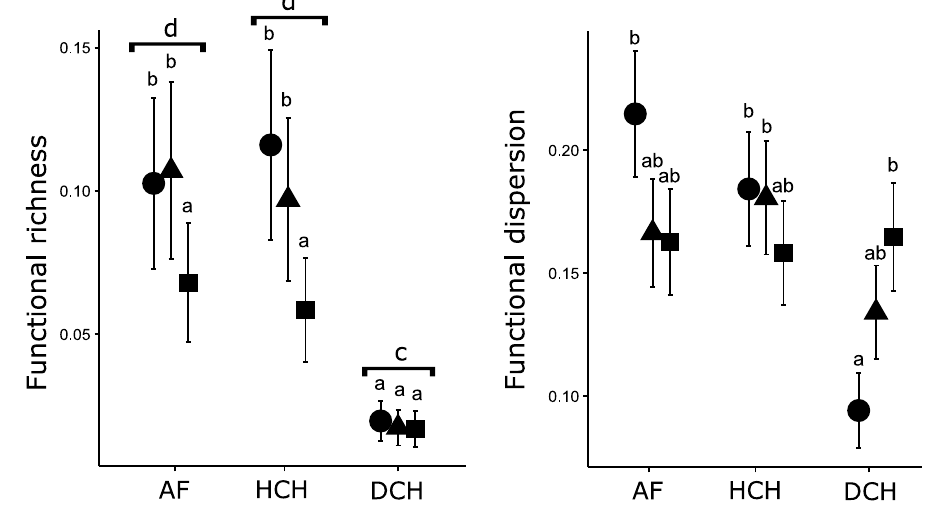
Figure 2. Dung beetle functional richness and dispersion among different regions and habitat types in subtropical forests of Argentina based on a GLMM analysis. AF: Atlantic Forest, HCH: Humid Chaco, DCH: Dry Chaco. Circles: native forest, triangles: forests with cattle, squares: open pastures. Different letters indicate significant differences ( p < 0.05). Brackets indicate differences in functional richness among regions.